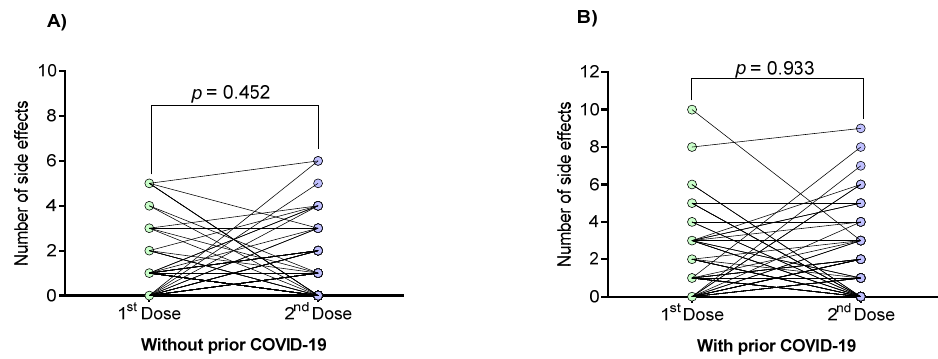
Figure 2. Numbers of vaccine-associated side effects in individuals with and without prior COVID- 19 after first and second doses. ( A ) Side effects in individuals without prior COVID-19; ( B ) Side effects in individuals with prior COVID-19. Data were calculated using the Mann–Whitney U-test. Values are provided as medians and interquartile ranges. Differences were calculated by the Wil- coxon signed-rank test.